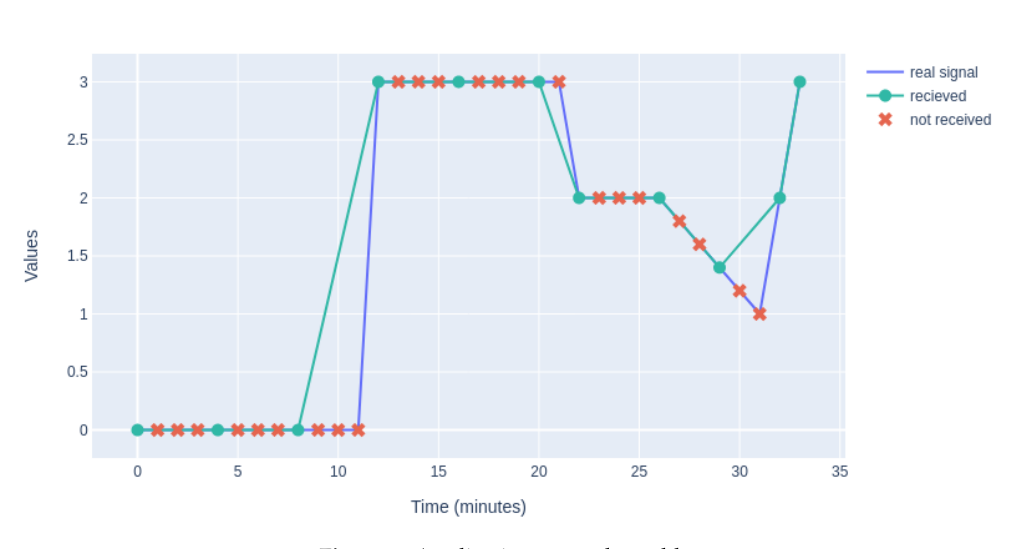
Figure 3. Application example